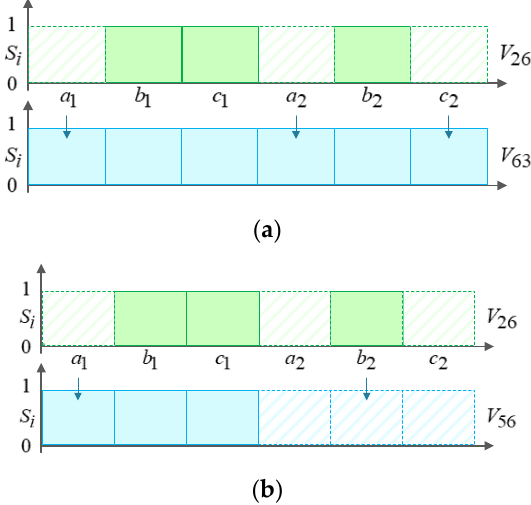
Figure 4. Switching transition: ( a ) Arbitrary null voltage vector selection and ( b ) using an optimal null voltage vector selection.